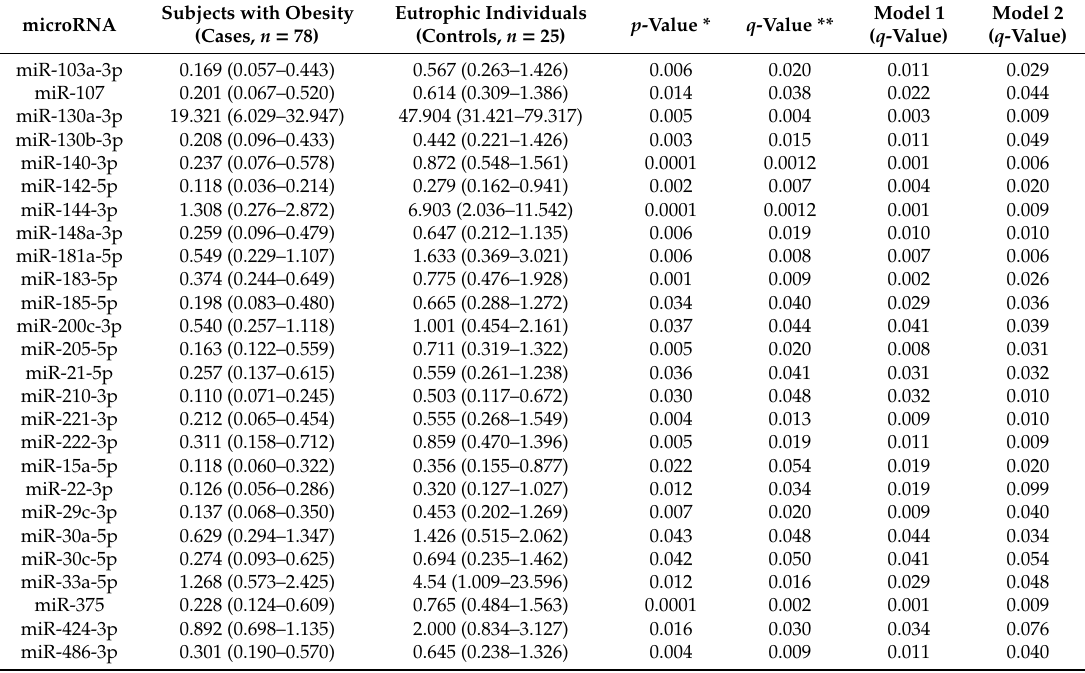
Table 2. Relation of 26 microRNAs whose expression profile in plasma is significantly di ff erent between cases with obesity and eutrophic controls.